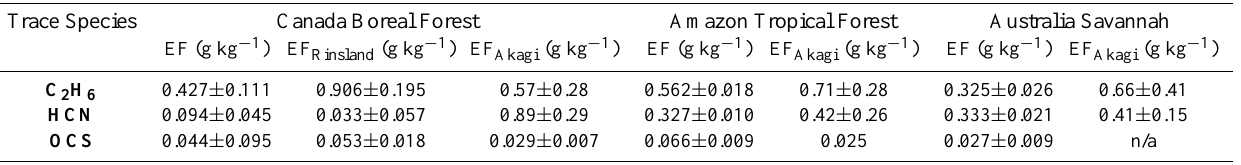
Table 4. ACE emission factors relative to CO with associate standard deviation (in gkg − 1 ) compared to emission factors calculated from airborne measurements (Akagi et al., 2011) of Boreal forests in Canada, Amazon tropical forest and the savannah of the Northern Territory in Australia. Previously calculated Boreal emission factors made by Rinsland et al. (2007) using ACE-FTS measurements of Boreal fires in Canada are also included in the